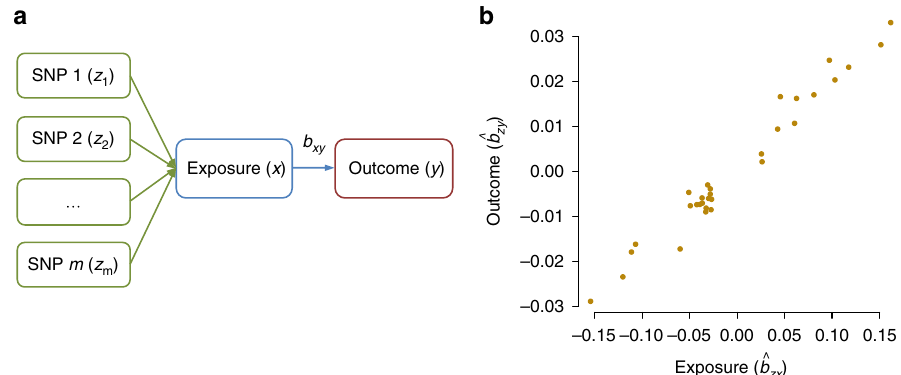
Fig. 1 Leveraging multiple independent genetic instruments ( z ) to test for causality. Shown in panel a is a schematic example that if an exposure ( x ) has an effect on an outcome ( y ), any instruments (SNPs) causally associated with x will have an effect on y , and the effect of x on y ( b xy ) at any of the SNPs is expected to be identical. This is further illustrated in a toy example in panel b that under a causal model, for the SNPs associated with x , the estimated effect of z on y ( ^ b zy ) should be linearly proportional to the estimated effect of z on x ( ^ b zx ) and the ratio between the two is an estimate of the mediation effect of x on y , i.e., ^ b xy ¼ ^ b zy = ^ b